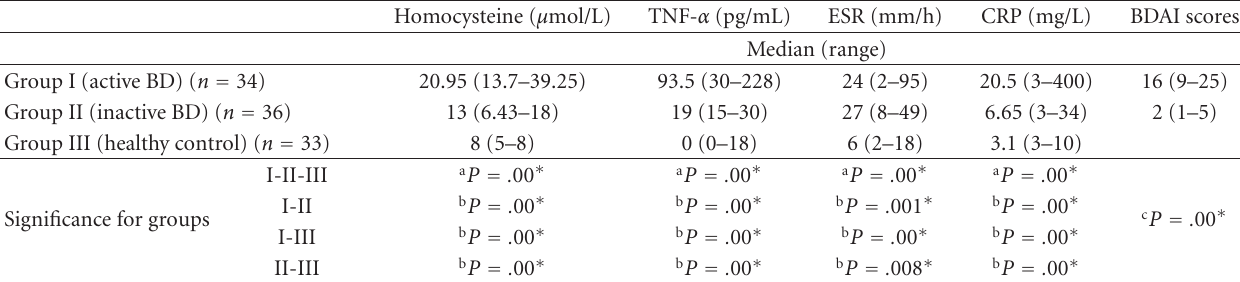
Table 1: Comparision of serum homocysteine, TNF- α , CRP, and ESR values and BDAI scores between groups.